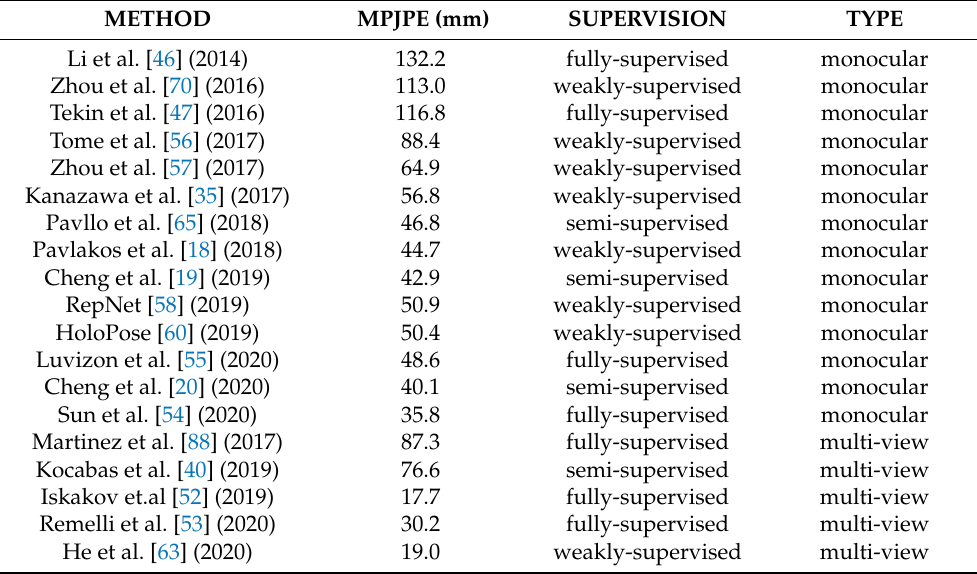
Table 2. Summary of the state-of-the-arts methods on Human3.6M dataset.